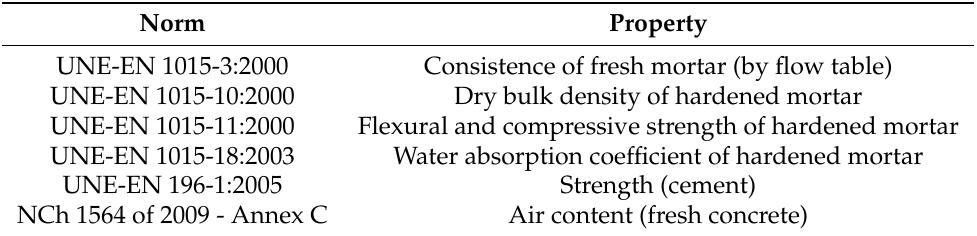
Table 5. Norms to determine materials